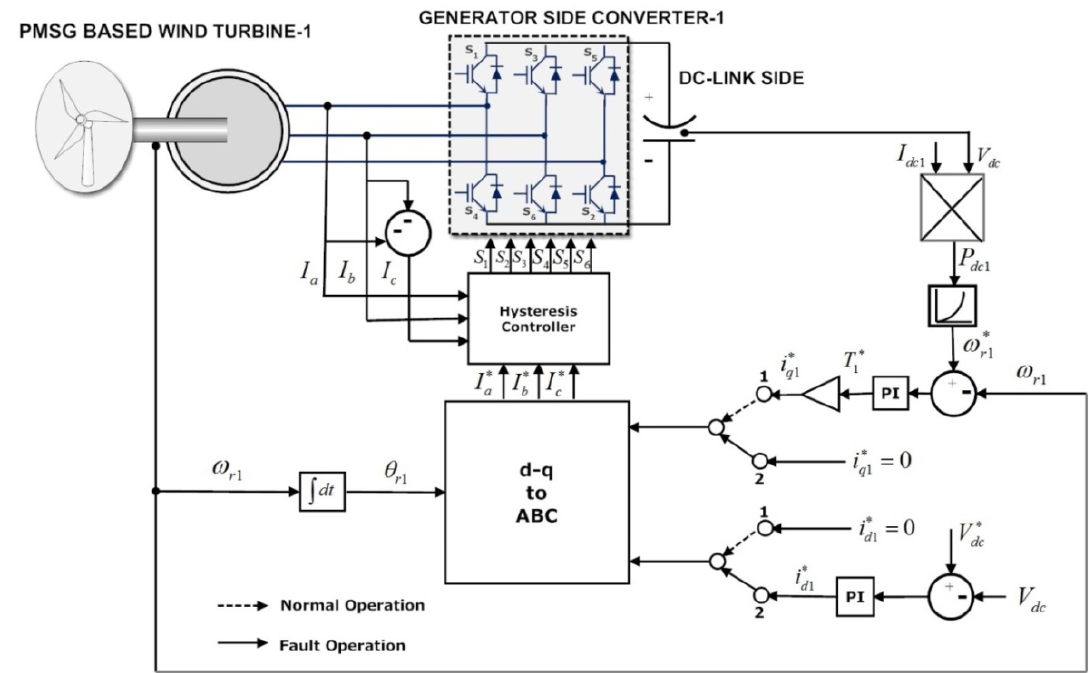
Figure 2. Control Strategy and operation of Generator Side Converters in Parallel Connected WT Topology under normal and fault conditions.